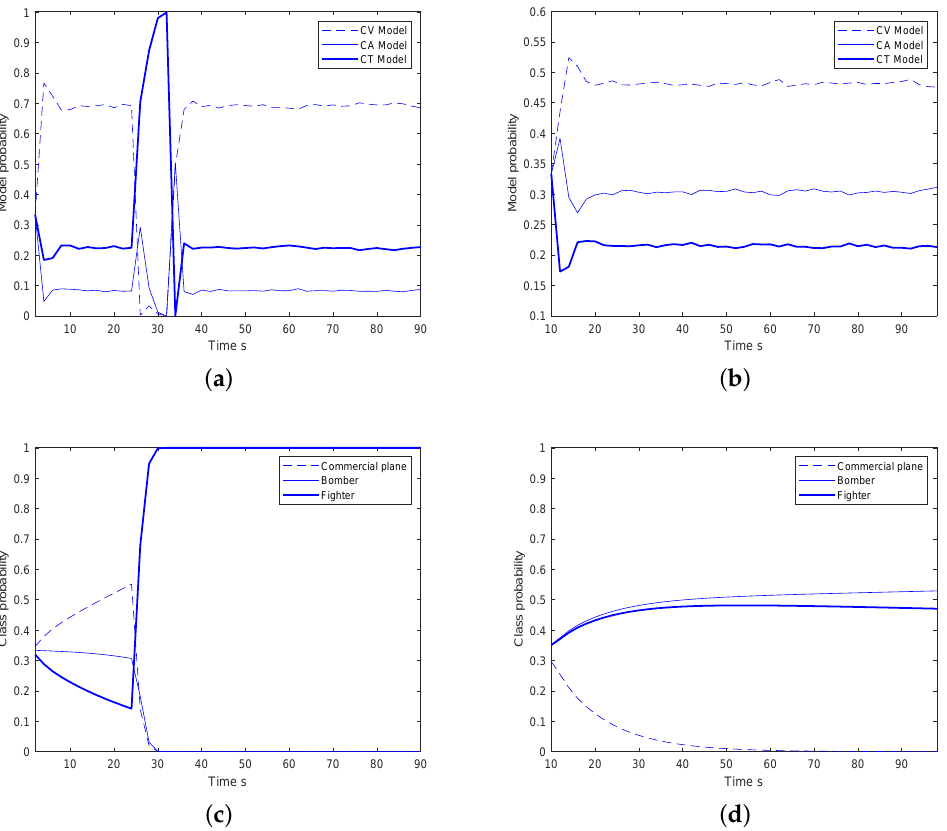
Figure 5. Classification results; ( a ) model probabilities of target 1, ( b ) model probabilities of target 5, ( c ) pignistic class probabilities of target 1, ( d ) pignistic class probabilities of target